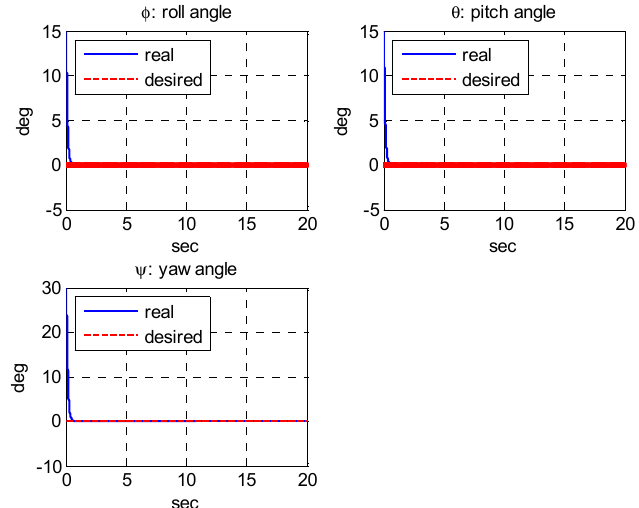
Figure 9. The attitude path with variable deviations and perturbations.